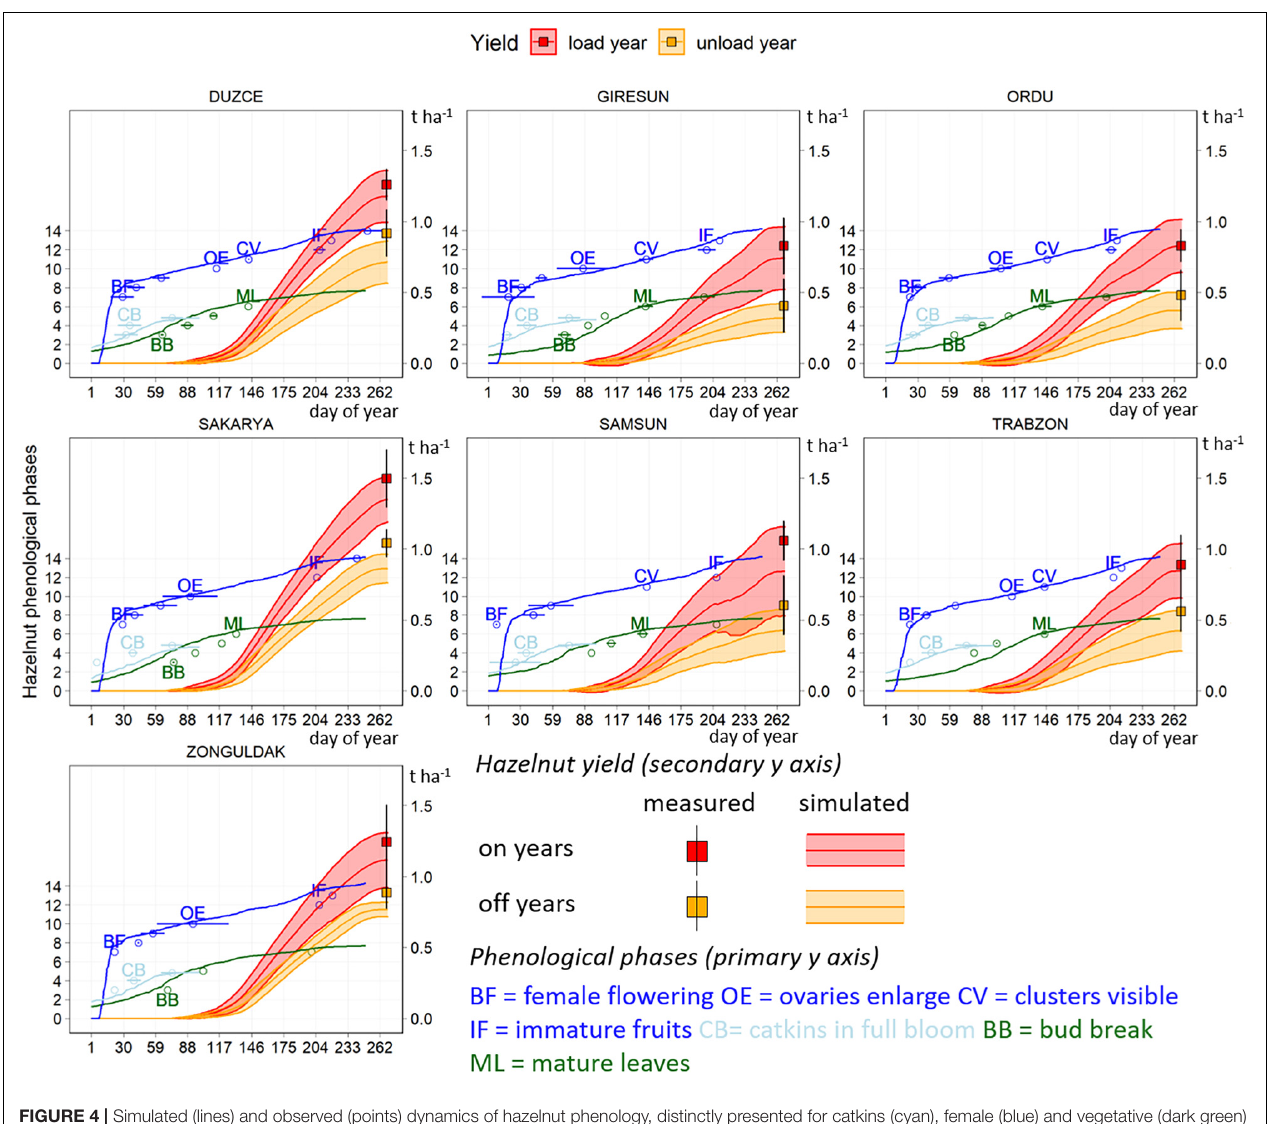
FIGURE 4 | Simulated (lines) and observed (points) dynamics of hazelnut phenology, distinctly presented for catkins (cyan), female (blue) and vegetative (dark green) phases. Simulated data refers to the average model outputs in 2004–2019, observed data to the field samplings collected in 2018 and 2019. Simulated dynamics of hazelnut yield are reported for on (red) and off (orange) years, along with official yield data (squares). Shades and horizontal and vertical error bars correspond to ± one standard deviation.